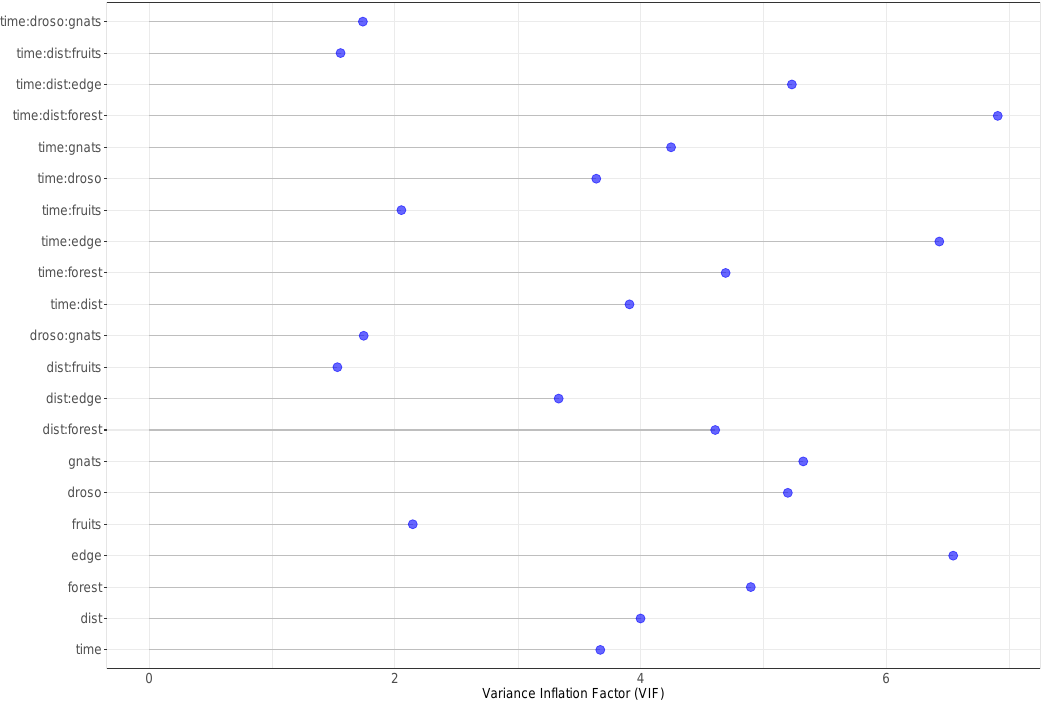
Figure A3. Variance inflation factors for explanatory variables. All values are below VIF =